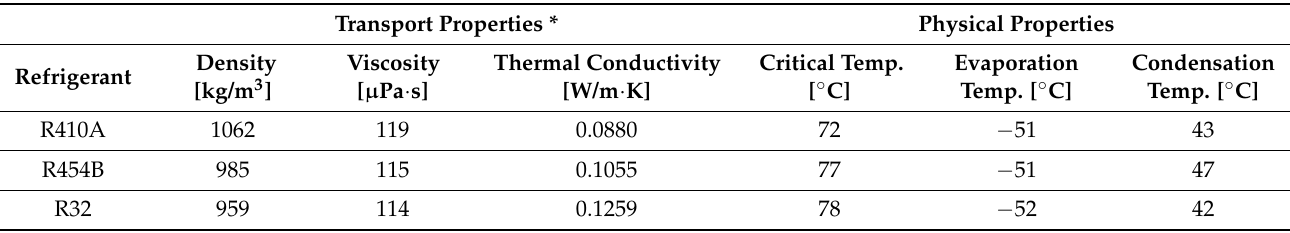
Table 7. Transport and physical properties for R410A and its substituents.